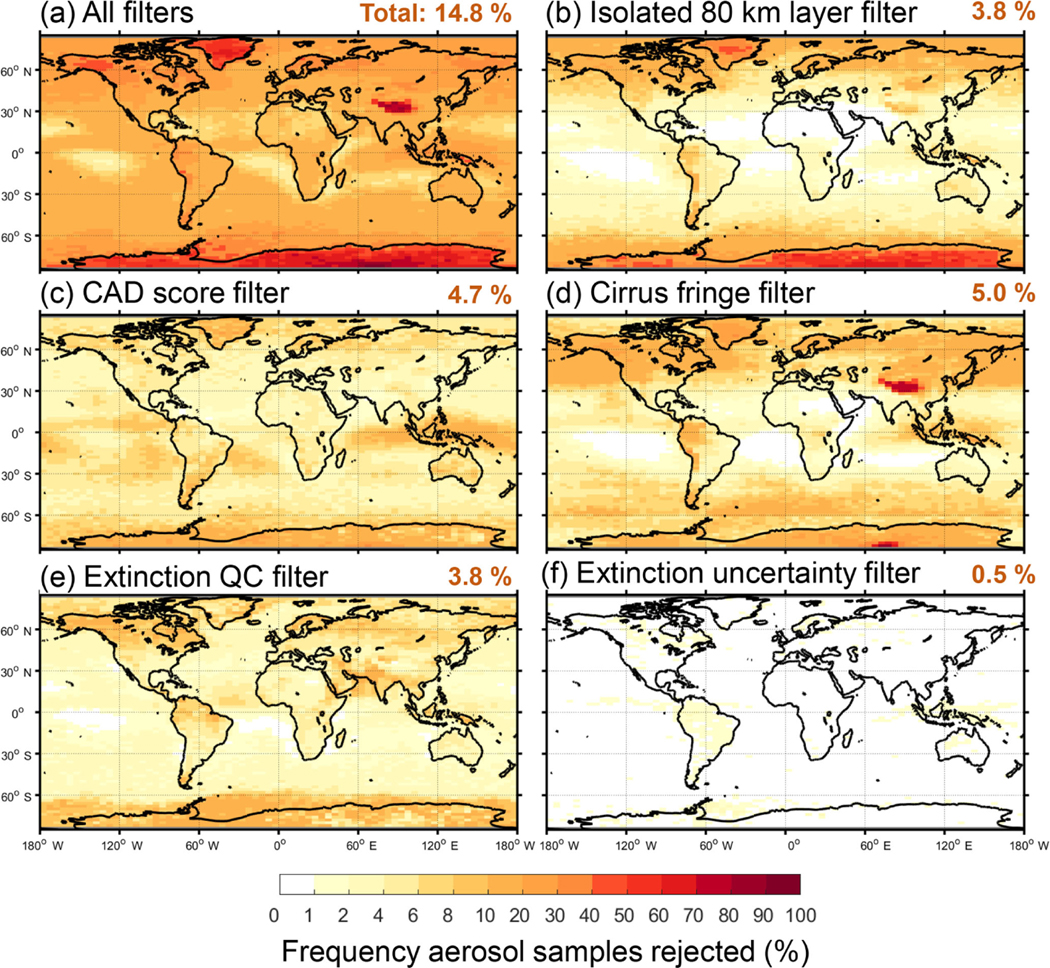
Frequency of level 3 aerosol samples rejected by the indicated filter out of all aerosol detected as reported by the level 3 product for 2007–2016 at night, all-sky. Global total rejection frequencies are indicated in the panel titles.